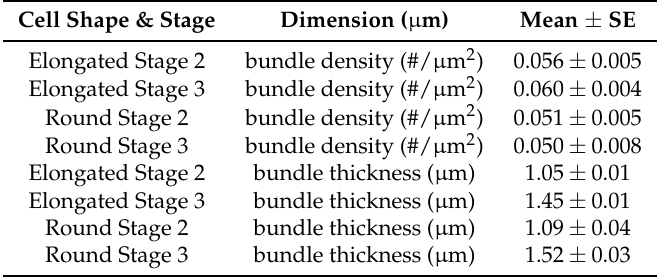
Table A2. SCW bundle feature sizes for rounded and elongated VND7-inducible cells. Bundle densities were measured from optical microscopy images. Bundle thicknesses were measured from confocal three-dimensional reconstructions. The data shown correspond to Mean ± Standard Error (SE) (n >